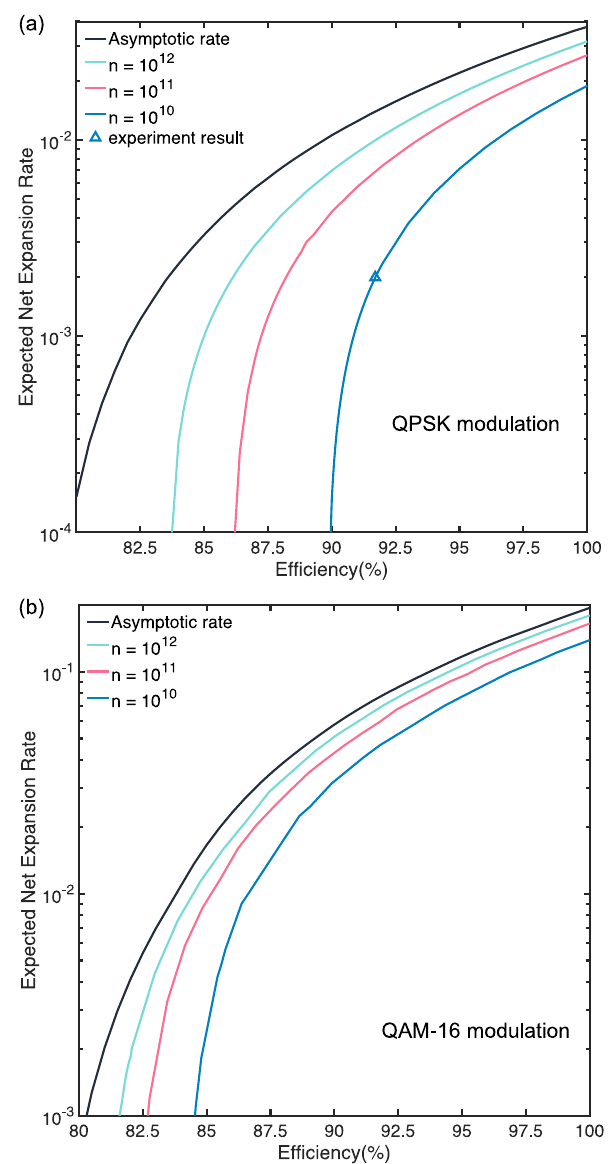
Fig. 3 | Performance Analysis 1. Expected net randomness expansion rate r net against system ef fi ciency η eff for different number of rounds n for ( a ) QPSK mod- ulation and ( b ) QAM-16 modulation. Security parameters used for the simulation: ε